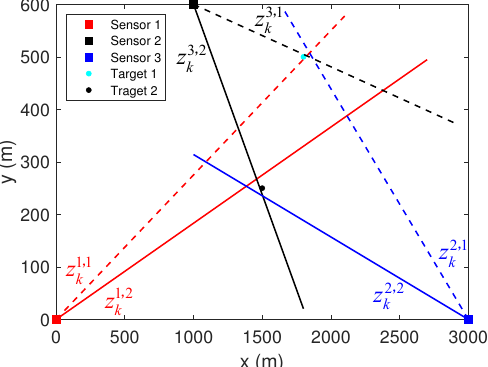
Figure 7. Scenario 1 with 2 stationary targets and 3 passive sensors.